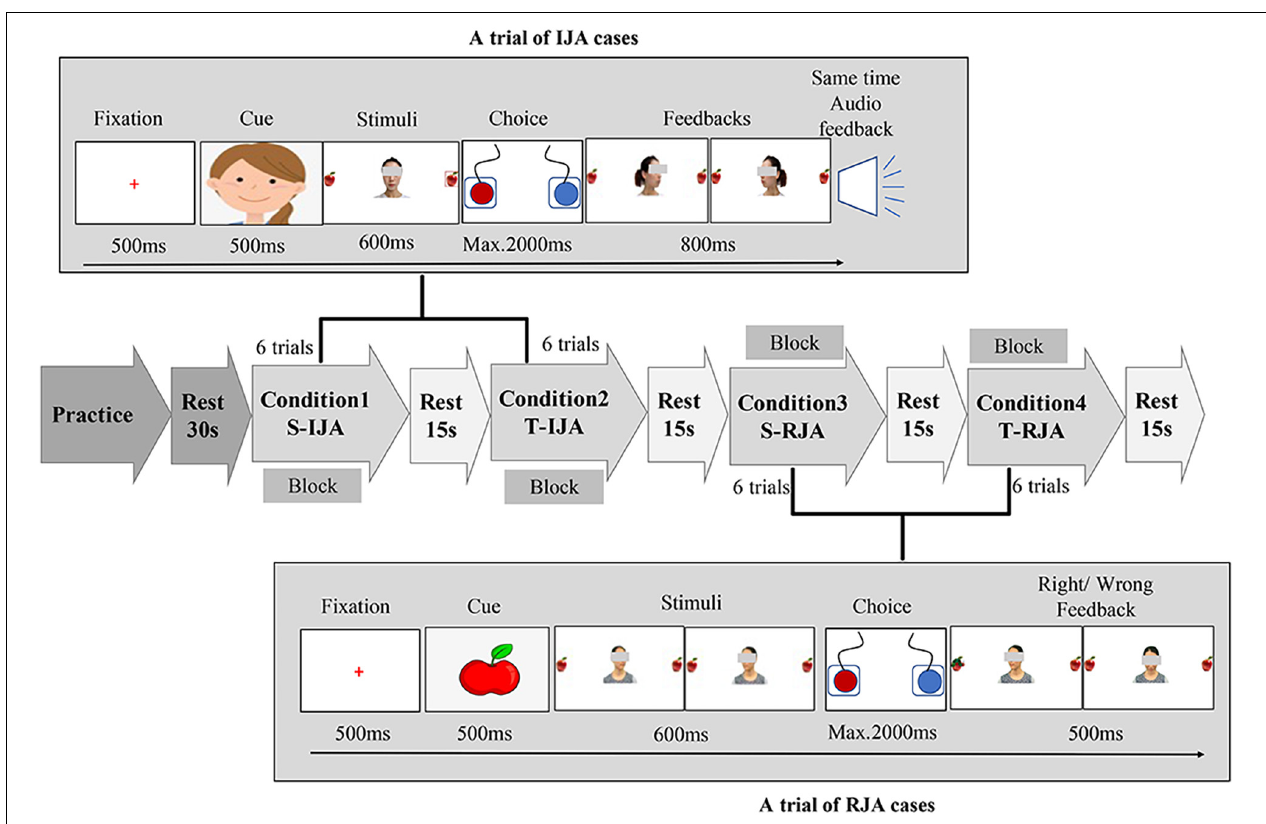
FIGURE 1 | Joint attention task schematic. The experiment consisted of two joint attention cases (i.e., IJA and RJA) under two kinds of social partners (i.e., stranger and teacher), and thereby was a 2 × 2 task (stranger/teacher × IJA/RJA) that actually included four conditions, i.e., condition 1 (S-IJA, corresponding to Stranger-IJA), condition 2 (T-IJA, corresponding to Teacher-IJA), condition 3 (S-RJA, corresponding to Stranger-RJA), and condition 4 (T-RJA, corresponding to Teacher-RJA). Each condition was a block that included 6 trials and would be repeated three times in the experiment. In the RJA trial (see the bottom of the figure), participants were instructed to follow a partner’s (stranger’s/teacher’s) gaze turned leftward or rightward via pressing the left or right button as quickly and accurately as possible. While, in the IJA trial (see the top of the figure), participants were asked to freely choose to shift the gaze of the interacting partner (teacher/stranger) by pressing the left or right button. The partner (teacher/stranger) shifted his/her gaze leftward or rightward dependent on the participant’s